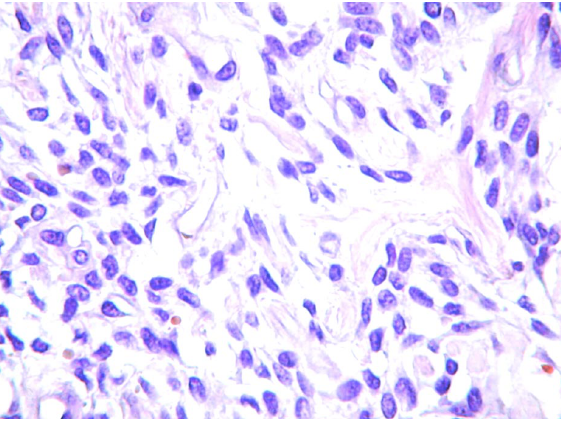
Figure 3 – Photomicrography showing neoplasia constituted by proliferation of short spindle cells, arranged in bundles, with ovoid nuclei, without hyperchromasia. Cytoplasm is delicate, pink, poorly delimited. There is no necrosis or hemorrhage (HE, X400)